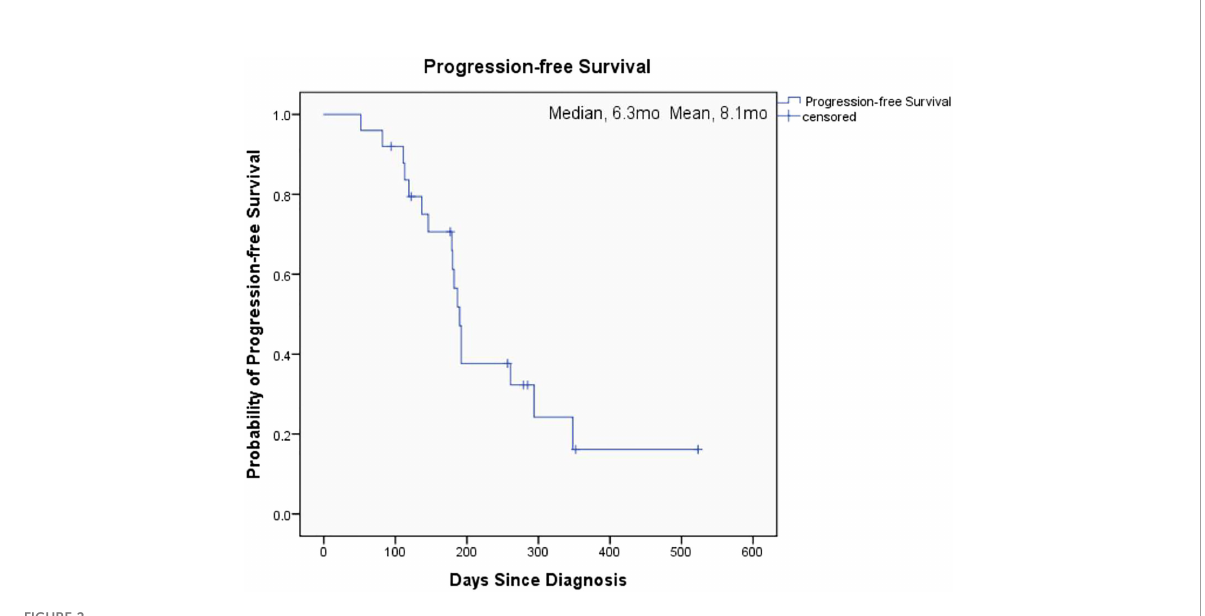
FIGURE 2 Kaplan-Meier Estimates of Progression-free Survival (all patients).